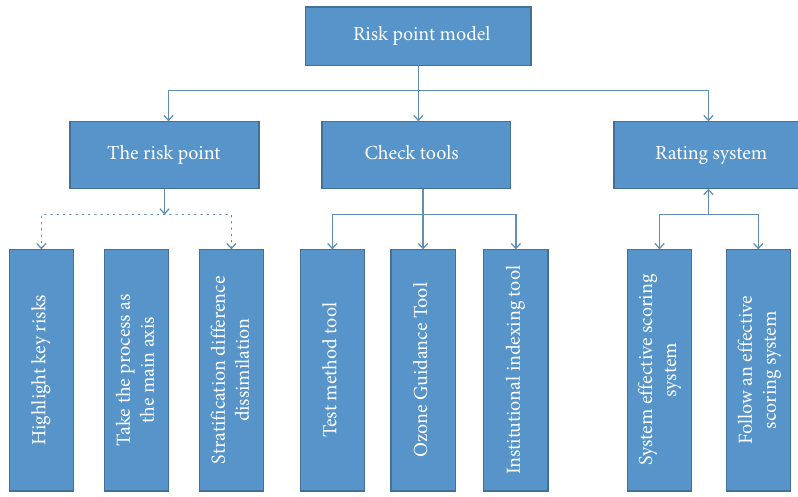
Figure 2: Setting of the risk point model of insurance company A